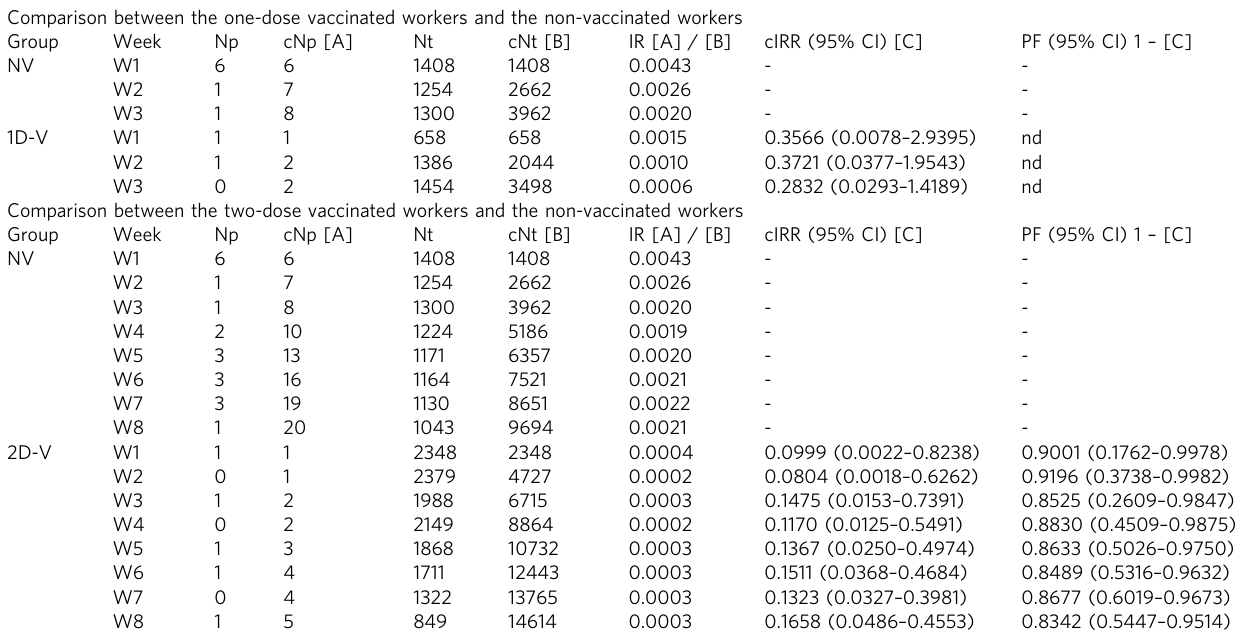
Table 1 Estimation of the cumulative incidence rate ratio and the related protection fraction against excretion of SARS-CoV-2 in saliva samples of vaccinated nursing home workers with COVID-19 mRNA BNT162b2 vaccine. Comparison between the one-dose vaccinated workers and the non-vaccinated workers